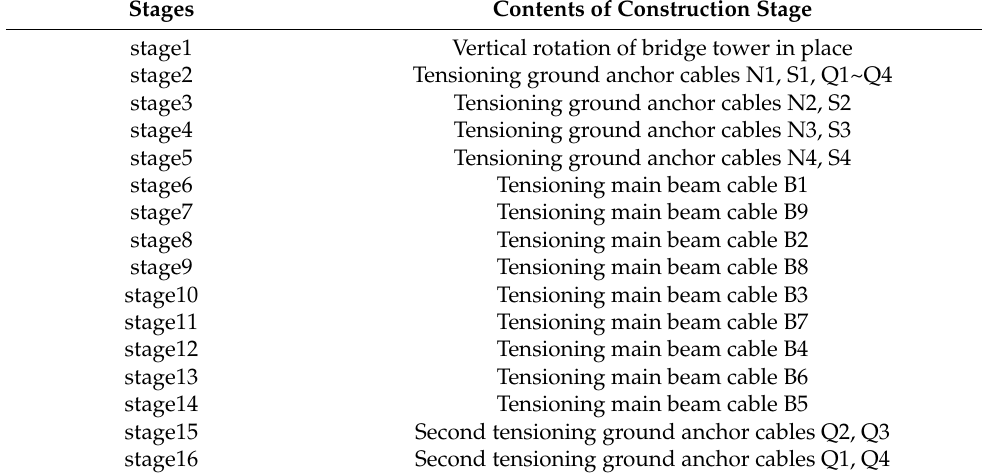
Table 2. Construction